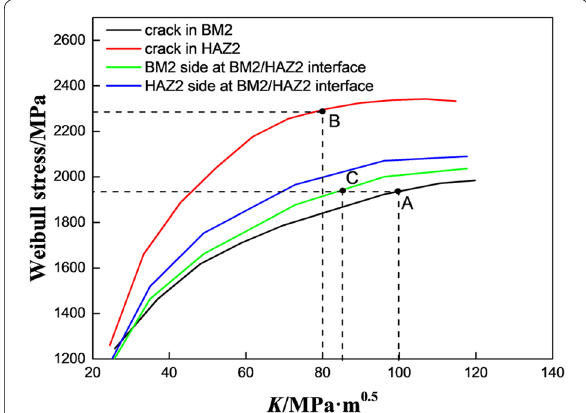
Figure 12 Relationship between Weibull stress and stress intensity factor for brittle interface